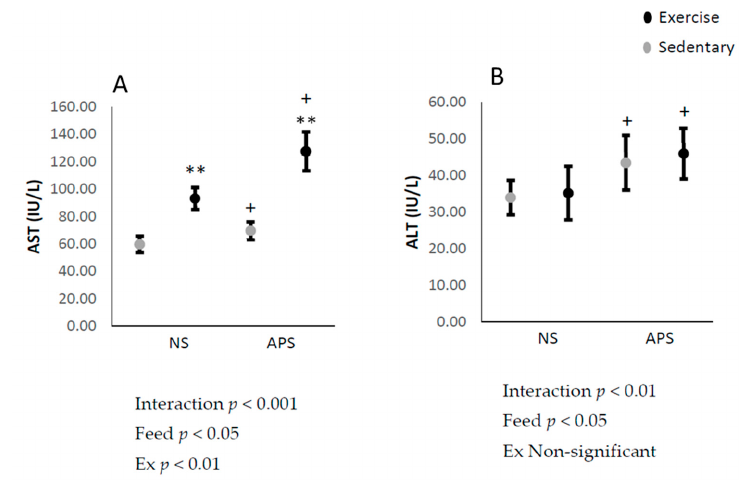
Figure 1. Means ± SEM plasma: ( A ) aspartate aminotransferase (AST) (control, n = 6; APS, n = 6; exercise (Ex), n = 4; Ex + APS, n = 4) and ( B ) alanine aminotransferase (ALT) (control, n = 6; APS, n = 6; Ex, n = 5;